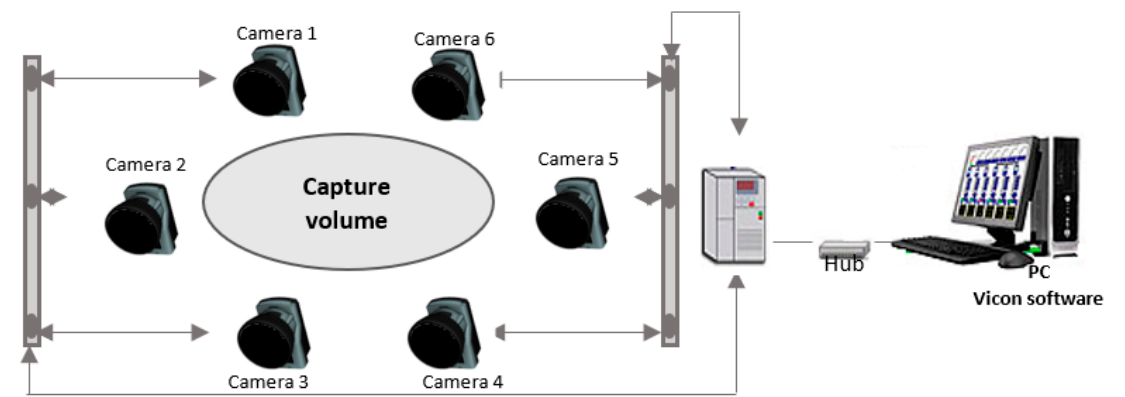
Figure 2. The used Vicon V460 system.